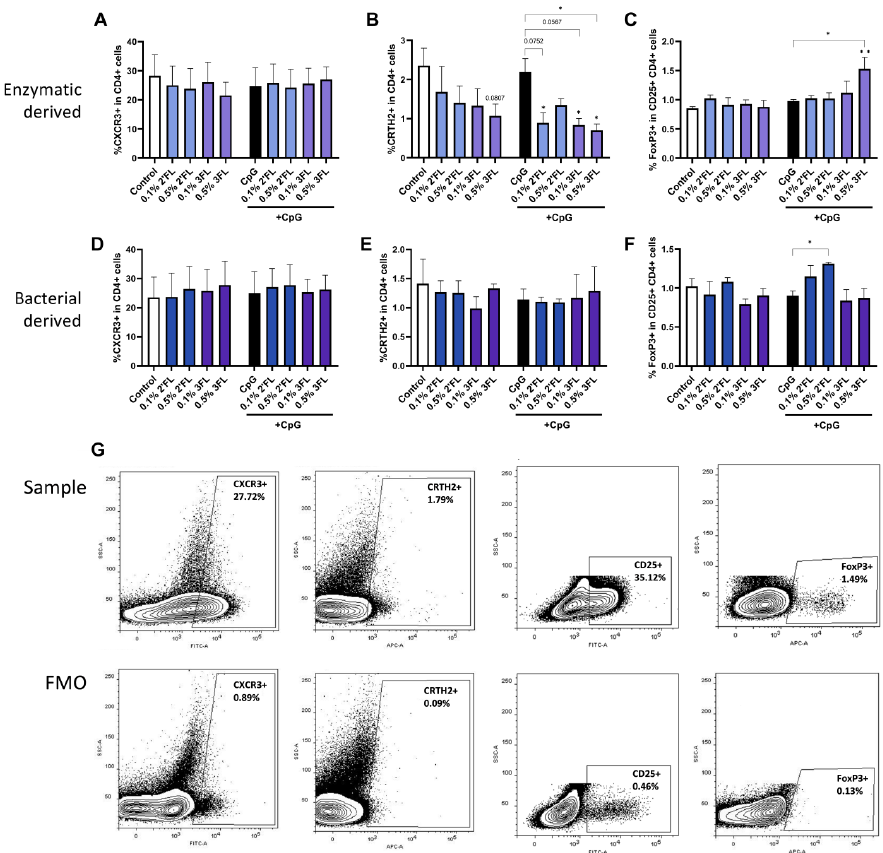
Figure 5. After 24 h coculture of HMOS and CpG exposed IEC cocultured with activated PBMCs, basolateral PBMCs were collected for phenotypical analysis by flow cytometry. Expression ( A , D ) of CXCR3, as well as ( B , E ) CRTH2 in CD4+ cells was assessed to represent Th1-type and Th2-type cells. Expression of ( C , F ) FoxP3 + in CD25 + CD4 + cells was assessed, representing Treg cells. The upper row displays results of enzymatic derived 2′ FL and 3FL, while the lower row displays bacterial de- rived 2′ FL and 3FL. ( G ) A representative sample and corresponding FMO controls displaying the gating strategy of Th cell subset markers. Data is analyzed by One-Way ANOVA followed by a Bonferroni post-hoc test, n = 3, mean ± SEM (* p < 0.05, ** p < 0.01). 3.5. IEC Are Required for 3FL Mediated Treg Polarization and IEC Enhance 2′ FL and 3FL Mediated Th1 Type and Th2 Type Cytokine Responses Epithelial-derived regulatory mediators such as galectin- 9, TGFβ and retinoic acid are known to contribute to the differentiation of Tregs [34 – 36]. Therefore, the role of IEC in the immunomodulatory effect of enzymatic 2′ FL and 3FL was investigated by